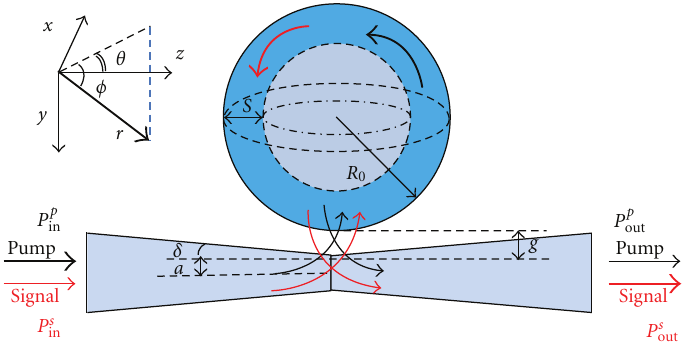
Figure 1: Schematic of a microsphere coupled to a tapered fiber.